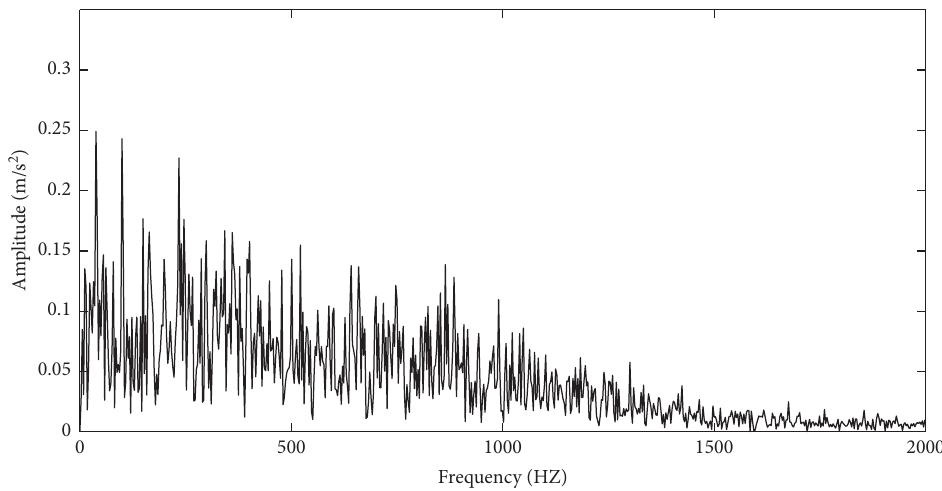
Figure 12: Frequency spectrums of IMFs after EMD.